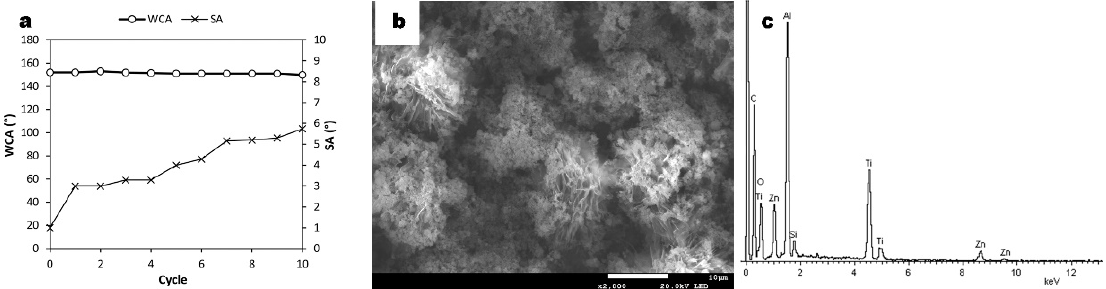
Figure 6. Durability test using P1200 SiC abrasive paper, which revealed that the surface was still superhydrophobic after 10 cycles: ( a ) the WCA remains higher than 150 ◦ and the SA is lower than 10 ◦ ; ( b ) FESEM image of the surface after the test showing the presence of TiO 2 as well as the flower-like structure and ( c ) EDS showing the presence of TiO 2 .